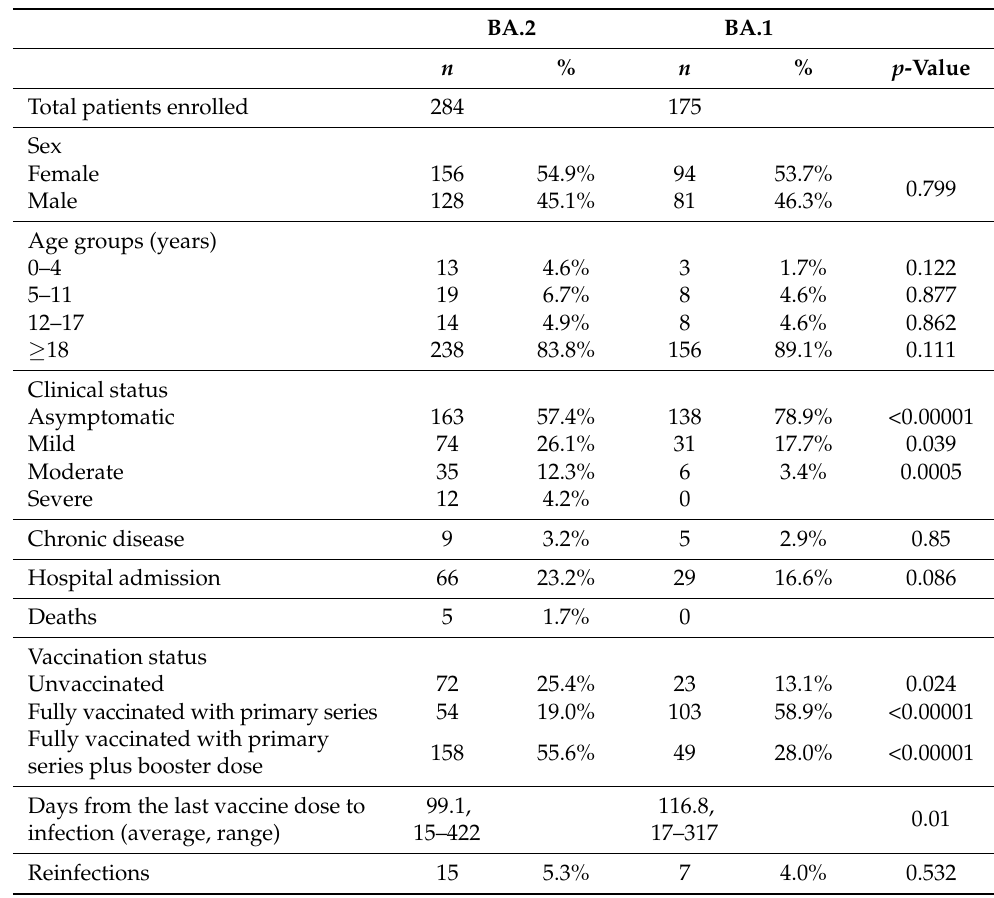
Table 1. Demographic and clinical characteristics of patients in the Apulia region of Italy infected with the BA.2 and BA.1 Omicron